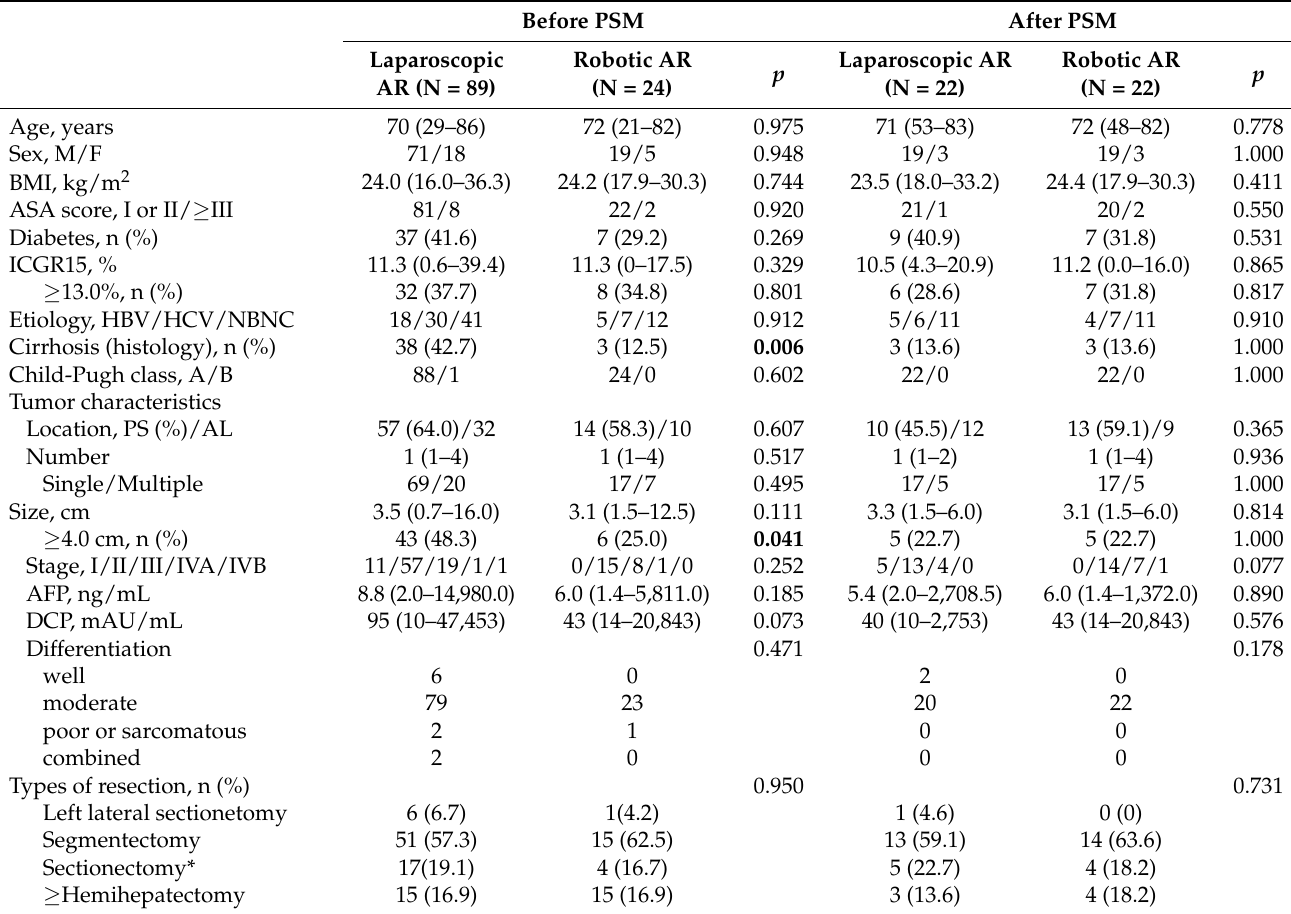
Table 6. Comparison of background data between laparoscopic and robotic AR for newly developed